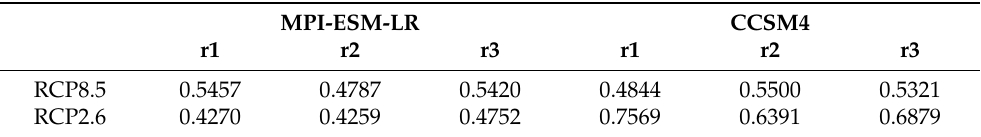
Table 2. Correlation coefficient between the upwelling velocity and the SW wind-stress modeled by MPI-ESM-LR and CCSM4 for the RCP8.5 and RCP2.6 scenarios. All the correlation coefficients are calculated from the detrended time series and are significant at the 95% significance